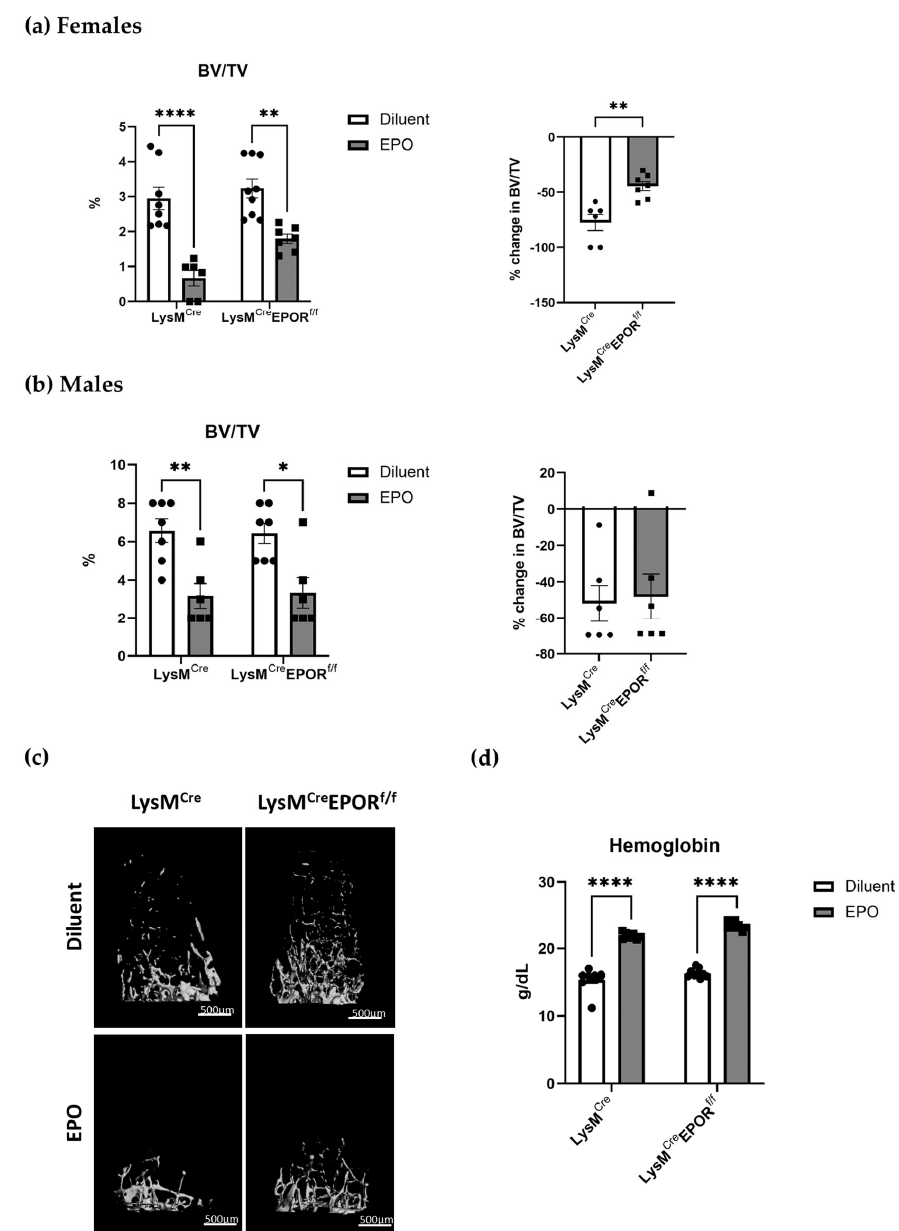
Figure 8. Monocyte-specific EPOR knockout attenuates EPO induced bone loss. µ CT analysis in the distal femoral metaphysis of diluent- and EPO-injected (180U/inj, 3 times/week for 2 weeks) 12-week-old ( a ) female (n = 6–9 in each group) and ( b ) male (n = 6–7 in each group) transgenic mice carrying a conditional knockout of EPOR in the monocytic lineage LysM Cre EPOR f/f mice compared to their LysM Cre controls. p values were calculated by 2–way ANOVA in the left panels. Data in the right panels are represented as the extent of reduction in trabecular bone volume/total volume (BV/TV) in EPO- vs. diluent-injected mice in each group and calculated by a Student’s t -test. ( c ) Representative 3D µ CT images of the distal femur of female mice described in ( a ). ( d ) Hemoglobin levels of EPO- versus diluent-treated LysM Cre or LysM Cre EPOR f/f female mice (n = 7–9 in each group). p values were calculated by 2-way ANOVA. * p < 0.05, ** p < 0.01, and **** p <